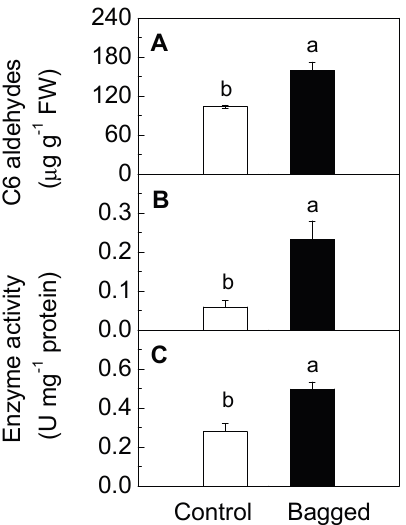
Figure 3. Effect of bagging treatment on the concentrations of C activity ( B ), and HPL activity ( C ) in peach fruit skin (2010 fruit season). Each value represents the mean ± standard error of three replicates. The significant differences are indicated with different letters (LSD,